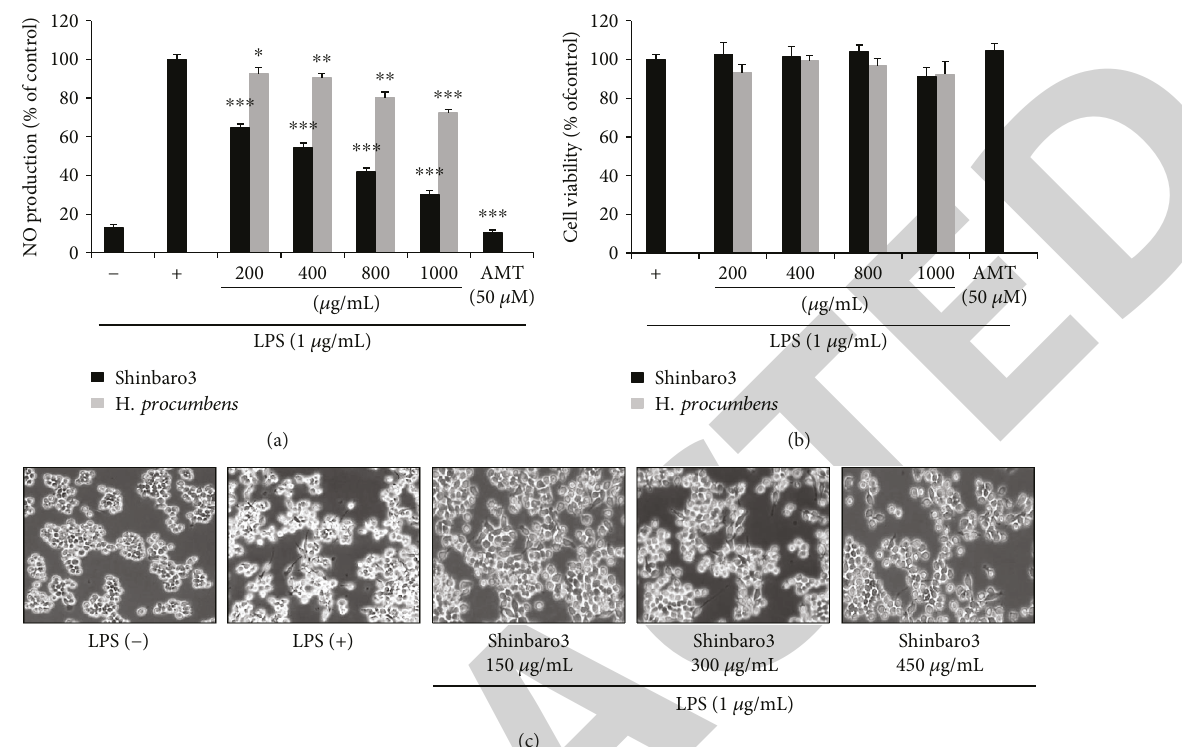
Figure 2: E ff ects of Shinbaro3 on NO production in LPS-stimulated RAW 264.7 macrophage cells. (a) RAW 264.7 cells were stimulated with LPS (1 μ g/mL) for 20 h in the absence or presence of Shinbaro3 (after hydrolysis) or H. procumbens extract (before hydrolysis) (200, 400, 800, or 1000 μ g/mL). The nitrite concentration in the supernatant was detected via the Griess reaction. (b) Cell viability upon Shinbaro3 or H. procumbens treatment for 20h was evaluated using the MTT assay, as described in Materials and Methods. (c) Morphological changes produced by Shinbaro3 in LPS-stimulated macrophages, photographed with an inverted phase-contrast microscope. Data are presented as the mean ± SD ( n = 3 ). ∗ p < 0 05 , ∗∗ p < 0 01 , and ∗∗∗ p < 0 001 versus LPS treatment